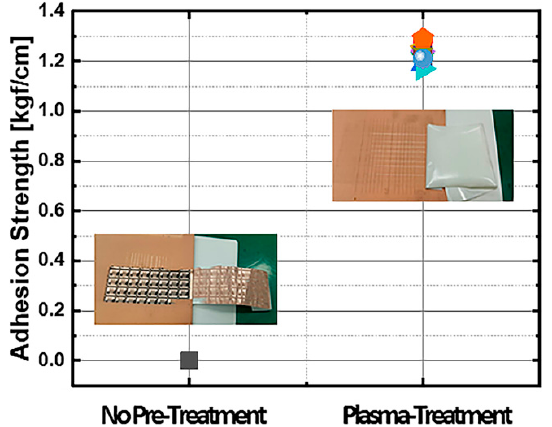
Figure 9. Effect of plasma treatment on adhesion strength between resin and Cu interface.